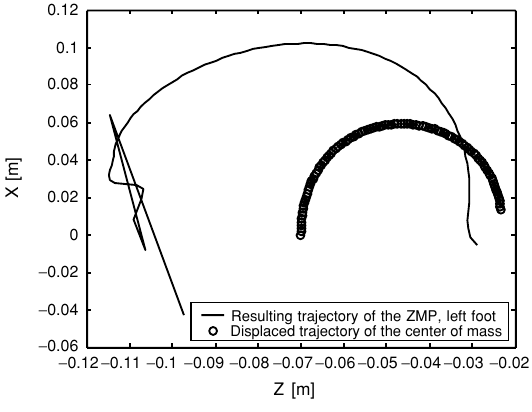
Resulting trajectory of the ZMP, left foot Displaced trajectory of the center of mass